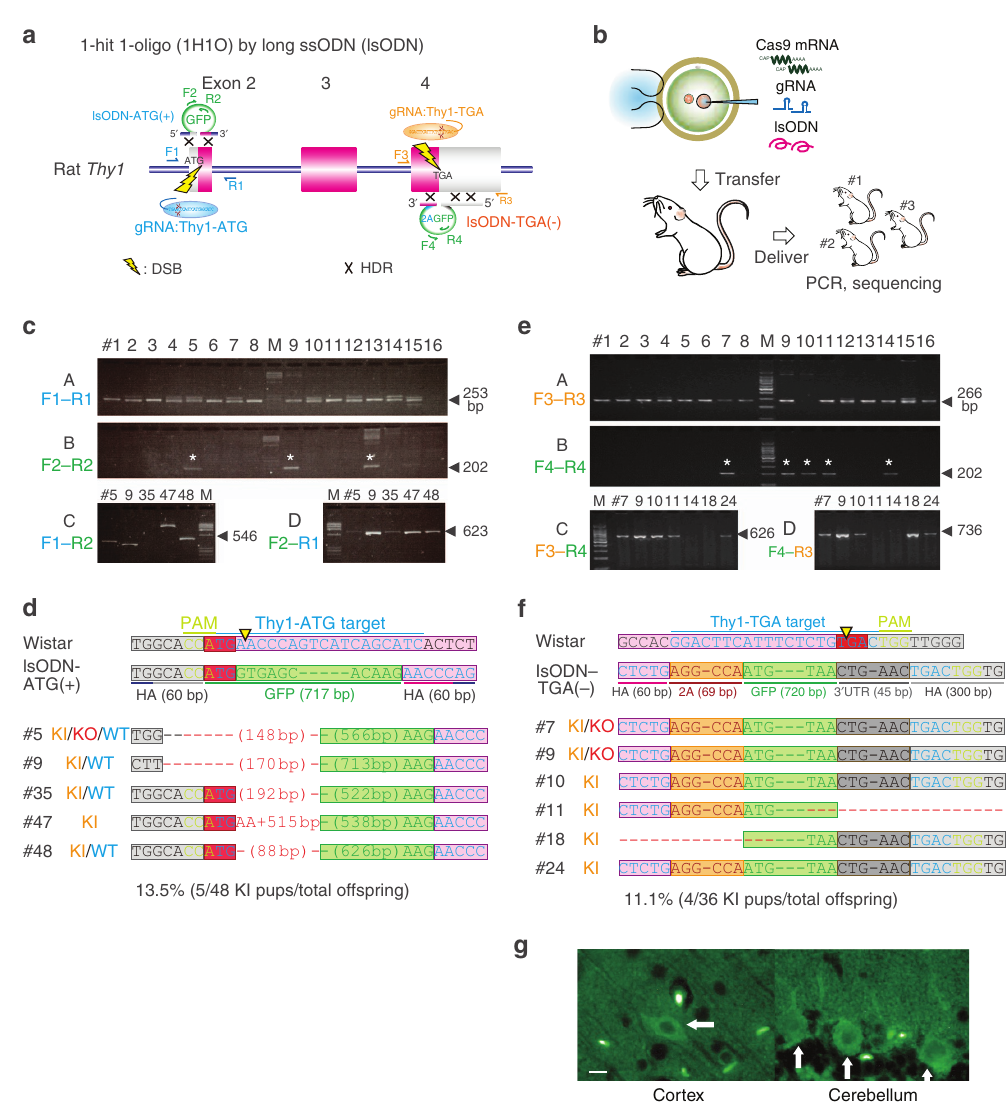
Figure 2 | lsODNs with CRISPR-Cas mediates KI at the rat Thy1 locus. ( a ) Schematic representation of the rat thymus cell antigen 1 ( Thy1 ) gene, gRNA targeting sites (Thy1-ATG and Thy1-TGA), primer sets (F1–4 and R1–4) and the lsODNs, each containing a GFP cassette and two 60–300bp homology sequences. ( b ) Schematic of gRNA, Cas9 mRNA and lsODN co-injection into rat fertilized eggs to generate founders carrying the KI mutation. ( c ) PCR analysis of pups (1–16) derived from co-injection of gRNA:Thy1-ATG, Cas9 mRNA and lsODN-ATG( þ ) with primer sets, F1,2 and R1,2, as indicated in a (see also Supplementary Table 3). Many pups show indel mutations at the targeted Thy1-ATG locus (also shown in Supplementary Fig. 4). (A) The product size of the wild-type Wistar allele (arrowed) is 253-bp. Some pups showed a GFP-positive PCR band (asterisk). (B) PCR-positive band with primer sets, F1 and R2 (C) or F2 and R1 (D) indicate ligation at either side of the Thy1-ATG and the GFP. Various indel mutations were found in c, but not in d, after comparison with the predicted PCR size indicated by arrows. ( d ) Sequence analysis of the GFP-positive pups showed HDR-mediated KI alleles with partial deletions of 5 0 -GFP coding sequences. ( e ) Co-injection of gRNA:Thy1-TGA, Cas9 mRNA and the complementary lsODN( (cid:2) ) with extended 300-bp homology arms into rat fertilized eggs. Many pups showed indel mutations at the targeted Thy1-TGA locus (Supplementary Fig. 6). (A) The product size of the wild-type Wistar allele (arrowed) is 266bp. Some pups showed a GFP-positive PCR band (asterisk). (B) PCR analysis of the pups with primer sets F3 and R4 (C) or F4 and R3 (D) showed the ligation at either side of Thy1-TGA and GFP. ( f ) Sequence analysis of 7 GFP-positive pups showed that four rats (numbers 7, 9, 10 and 24) carried complete sequences of HDR-mediated KI alleles, including rat Thy1, 2A peptide and GFP. The remaining three failed to be sequenced at the conjunction sites. ( g ) KI rat number 24 showed GFP-positive neurons in the cortex and GFP-positive Purkinje cells in the cerebellum (arrows). Blood vessels were also GFP positive. Scale bar, 10 m